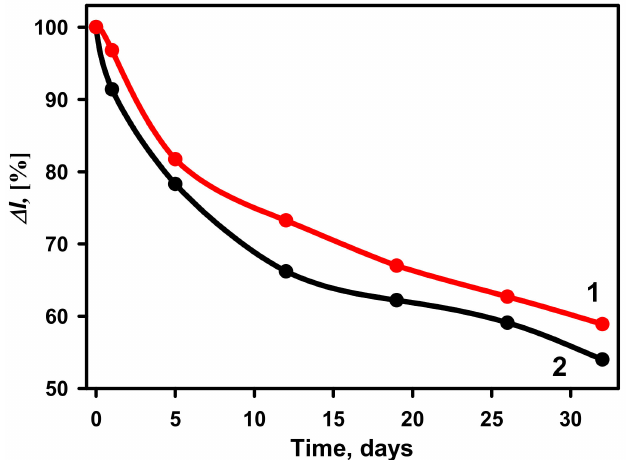
Figure 8. The stability of biosensors based on GA-GOx-SAM/DGNs/GR (curve 1, red dots • ) and GA-GOx/DGNs/GR (curve 2, black dots • ) electrodes. The amperometric response was measured in 0.05 M SA buffer with 0.1 M KCl (pH 6.0) and 6.0 mM